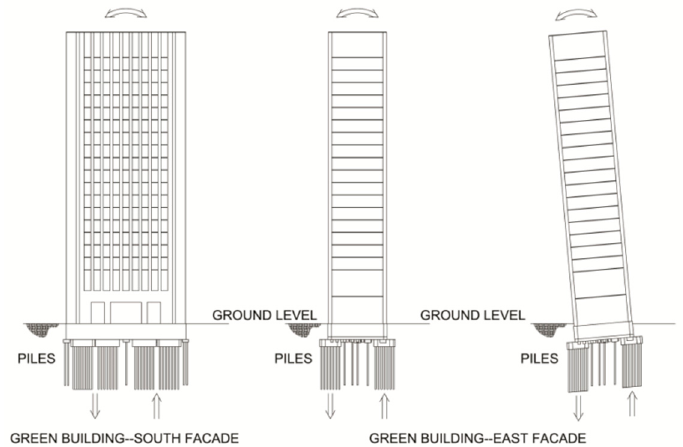
Figure 12. Distribution of vertical accelerometers in the Green Building’s basement level.